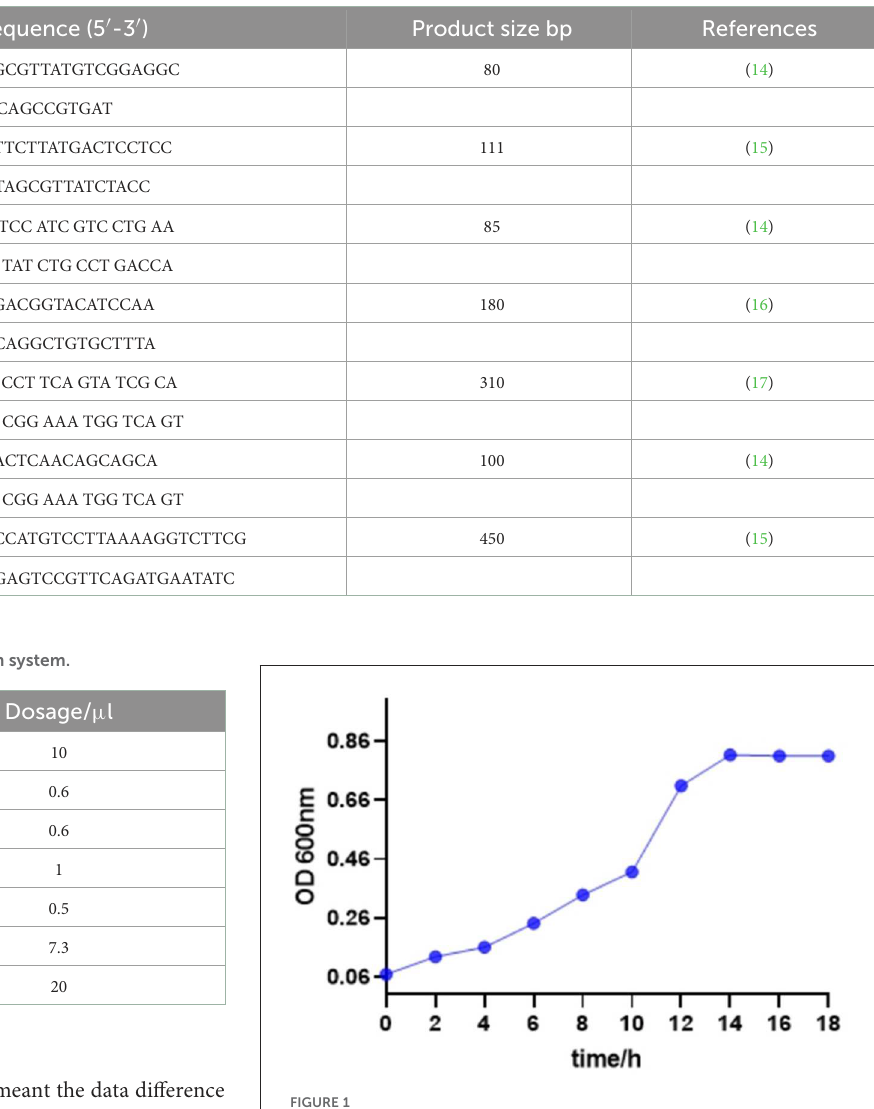
growth curve after 10h. Compared with the control group, when the SEDQS concentration increased from 1/4 MIC, 1/2 MIC, MIC, and 2MIC, the bacteria growth decreased, respectively. At 2 MIC and MIC, the growth of bacteria did not show an obvious bacteria by